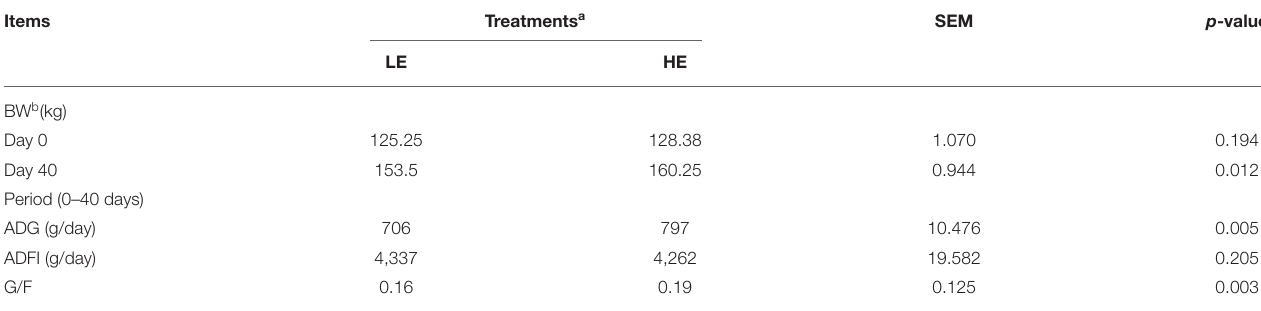
TABLE 2 | Effects of diets with different energy levels on donkey production